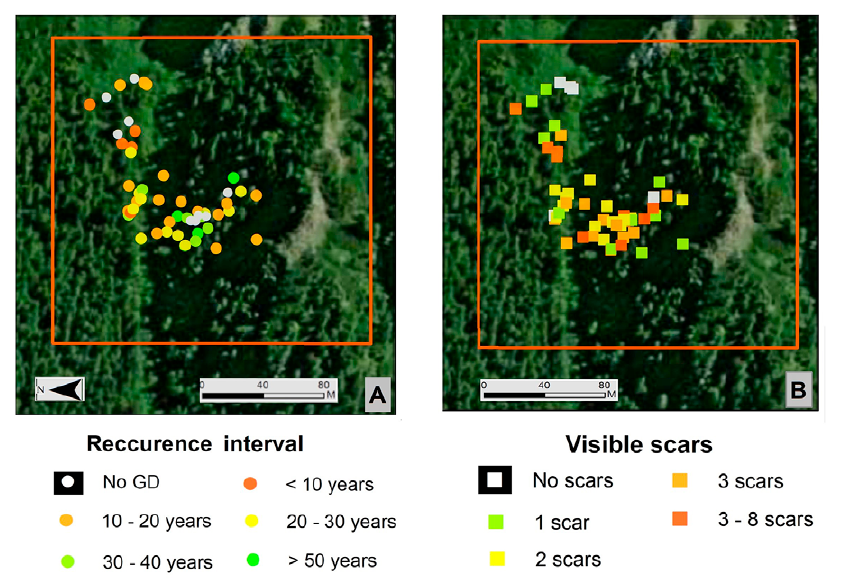
Figure 10. Recurrence interval classes for each tree - dendrogeomorphic approach (A) and visible scars counting approach